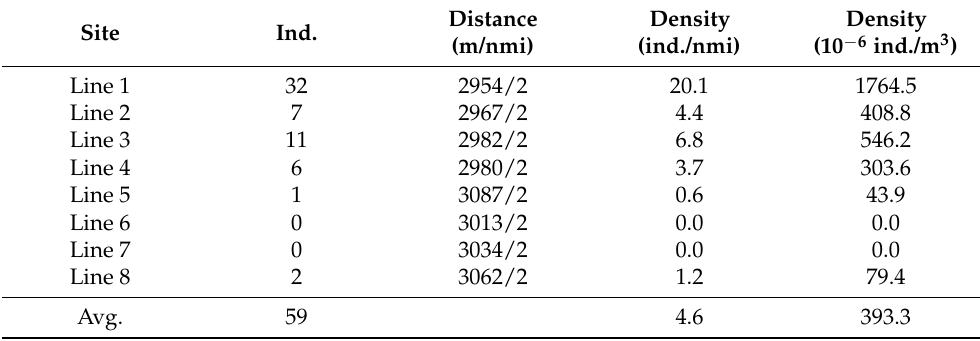
Table 12. Distribution density of jellyfish using the echo counting method in the Gijang coastal waters sea (7/22).